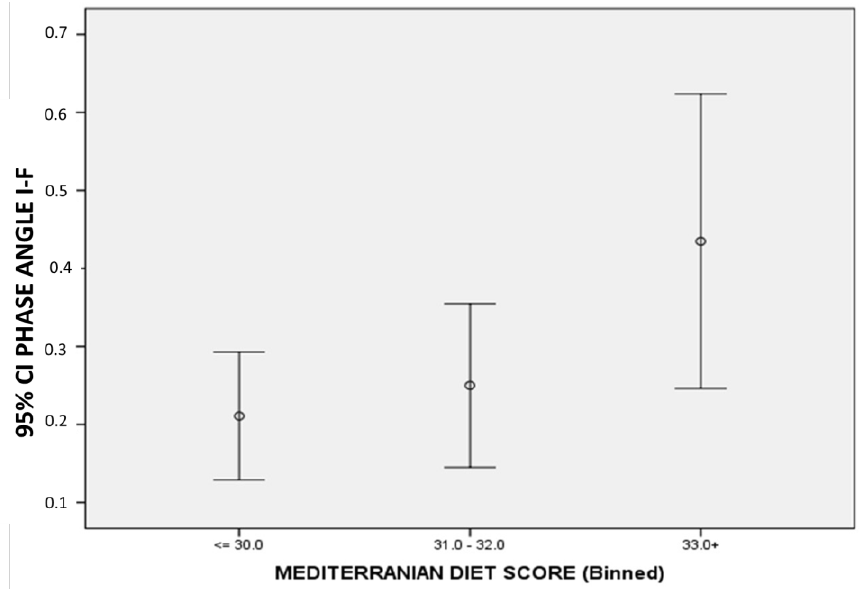
Figure 2. Relation of baseline MedDietScore to changes in phase angle during therapy. Changes in phase angle represent differences between initial and final values. MedDietScore: Mediterranean diet score.